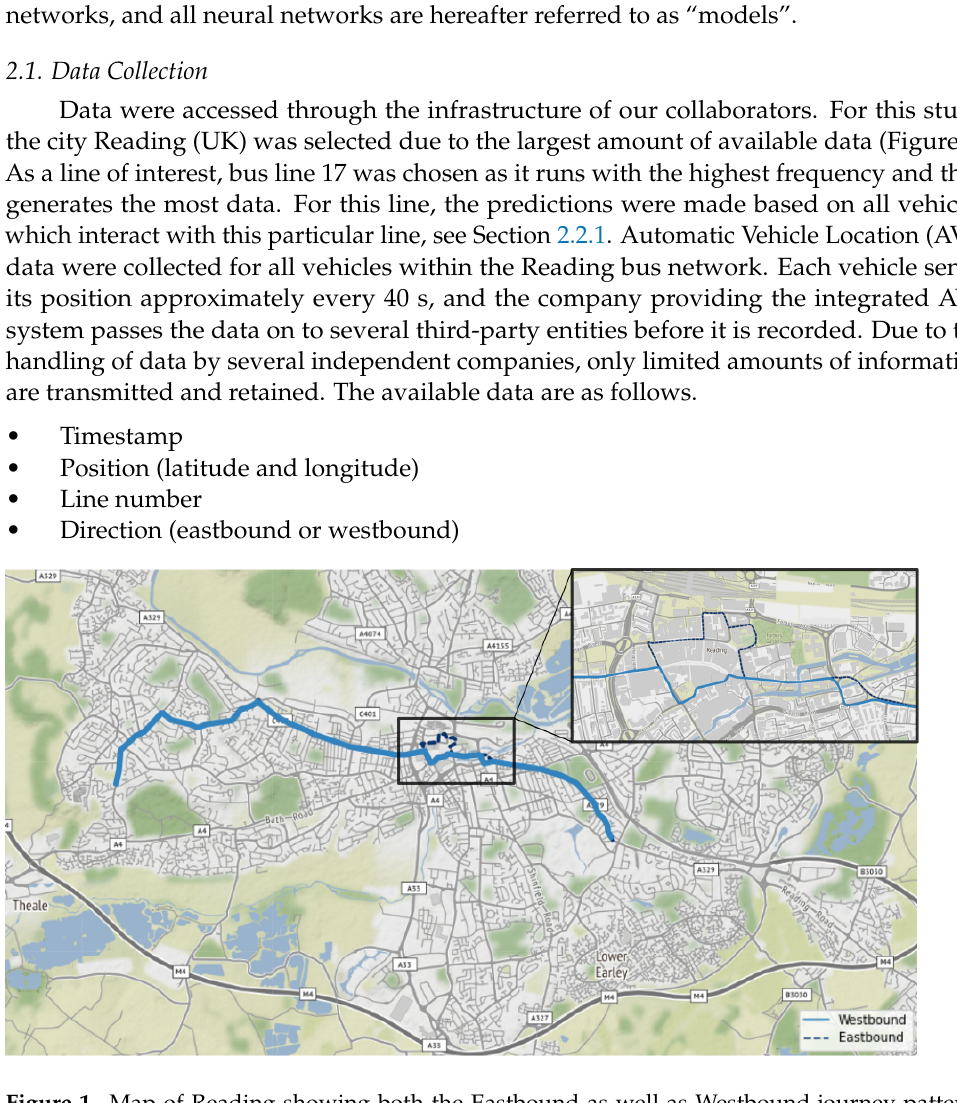
Figure 1. Map of Reading showing both the Eastbound as well as Westbound journey patterns. The blow-out area shows the city centre where the line negotiates a one-way system and therefore, runs on two separate routes depending on the direction of